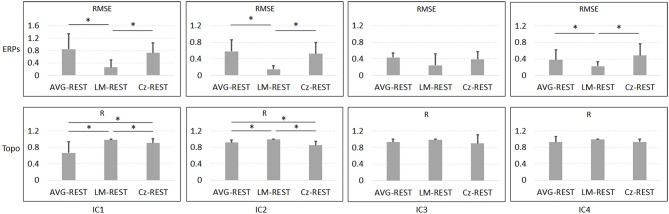
Results of one-way repeated ANOVA (p < 0.05) and post hoc paired t-test (*p < 0.05) for real data. The vertical axis of the first row is the mean RMSE (with standard deviation) between the ICA-extracted ERPs with the AVG/LM/Cz reference and with the REST reference, while the vertical axis of the second row is the mean spatial correlation (with standard deviation) between the ICA-extracted topographies with the AVG/LM/Cz reference and with the REST reference. Columns from left to right correspond to the ICA components (IC1-IC4).